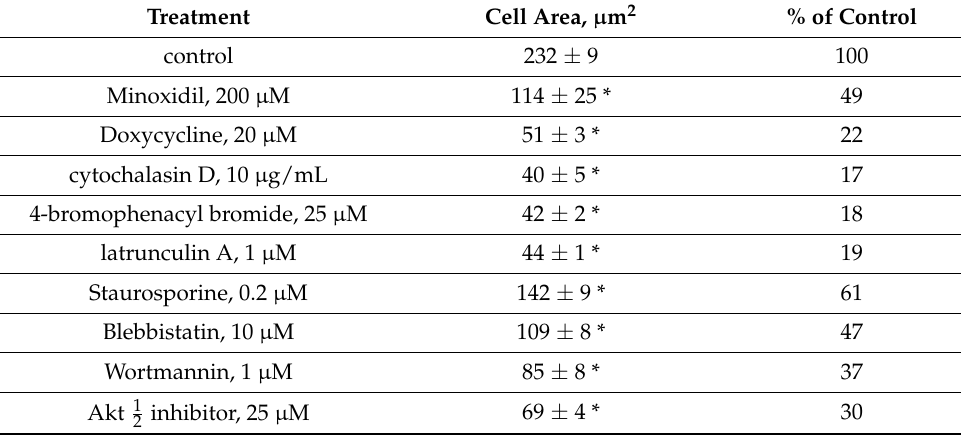
Table 1. Area of neutrophils attached to fibronectin in the presence of the inhibitors being tested. Data presented are mean ± SEM derived from cell area measurements on 15–20 neutrophils obtained with scanning electron microscopy in three similar experiments for each inhibitor. *— p < 0.0001 as compared to the control value. The cell area of the attached neutrophils was quantified using ImageJ image